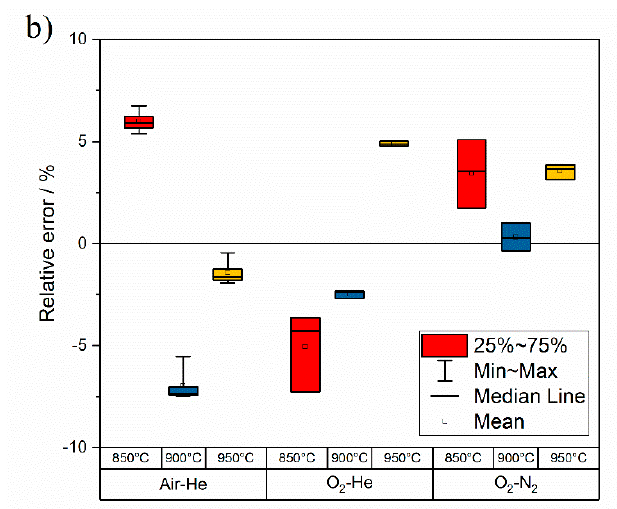
Figure 10. Summary of supported membrane calibration procedure. ( a ) comparison of measured O 2 flux data and model predictions at different operating temperature and sweep flow rate; ( b ) relative error between measured data and model.